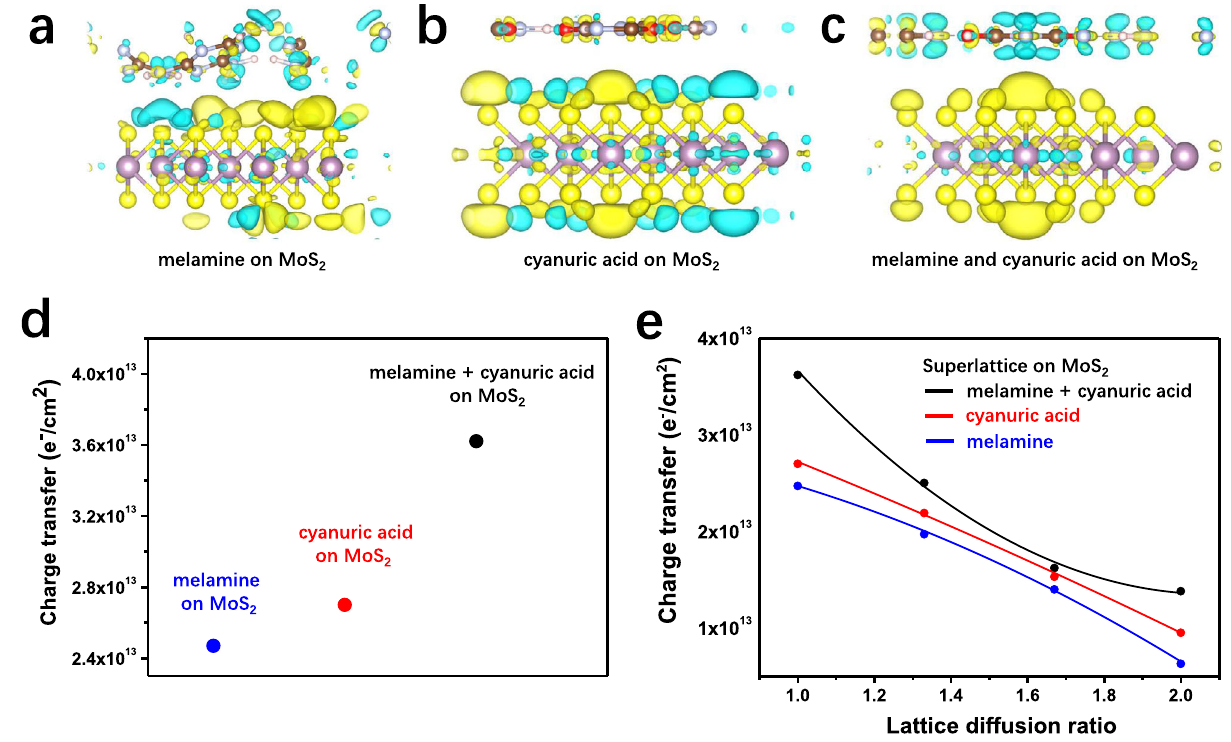
Fig. 1 Simulated charge transfer from melamine (M), cyanuric acid (CA), and co-assembled structure to MoS 2 monolayer. a – c The side-view differential charge density images of a melamine (M), b cyanuric acid (CA), and c co-assembled network (CA·M) on monolayer MoS 2 . The yellow and light blue regions in panels indicate the charge accumulation and depletion, respectively. d The magnitude of the charge transfer in tightly packed molecule adlayers. e Charge transfer as a function of unit cell size for melamine, cyanuric acid, and co-assembled networks on monolayer MoS 2 .